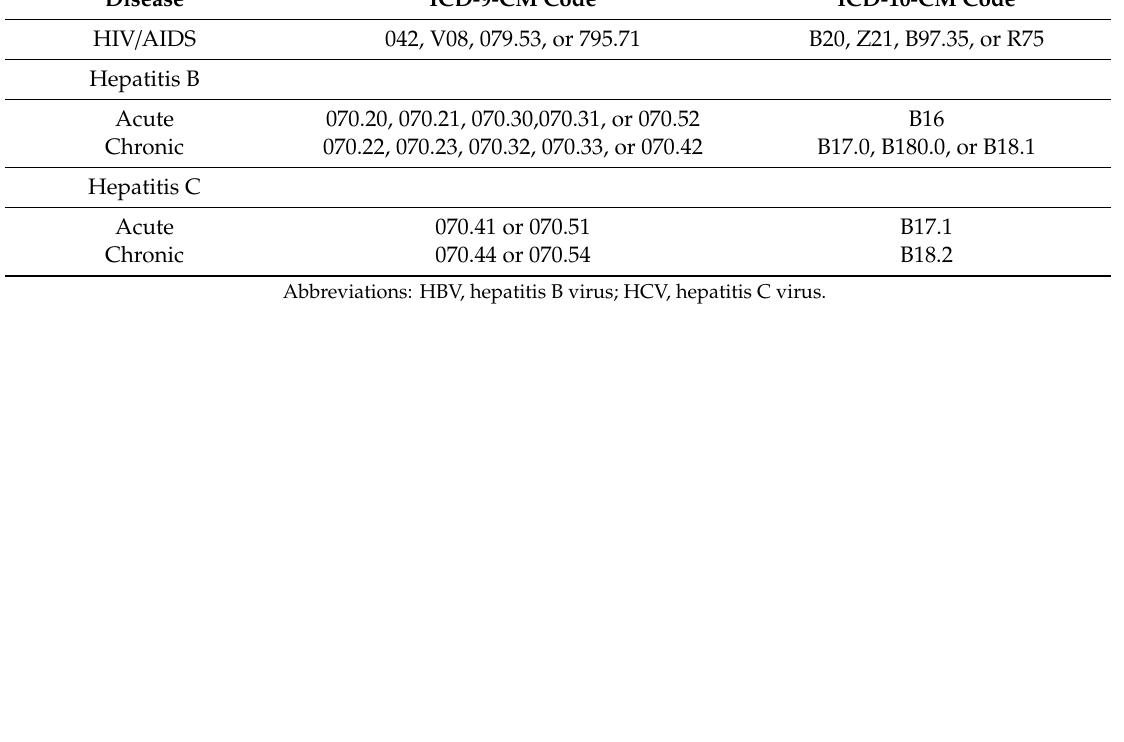
Table S1: Number and Percentage of Medicare Fee-for-Service Beneficiaries With or Without Opioid-related Claims Among Those Who Had Claims for HIV, HBV, or HCV, United States, 2015; Table S2: Number and Percentage of Medicare Fee-for-Service Beneficiaries Who Had Claims for Opioid-related Diagnoses, by Those with Claims for Opioid Overdose, United States, 2015; Table S3: Number and Percentage of Beneficiaries with Opioid Overdose Claims, a by Demographic Characteristics Among the Medicare Fee-for-Service Beneficiaries Who Had or Did Not Have HIV, b HBV, or HCV b Claims, United States, 2015; Table S4: Adjusted Odds Ratios (aORs) and 95% Confidence Intervals (CIs) for Association of Opioid Overdose Claims with ≥ 1 HIV, HBV, or HCV Infection Among Medicare Beneficiaries with Non-overdose Opioid-related Claims, United States, 2015; Table S5: Adjusted Odds Ratios (ORs) and 95% Confidence Intervals (CIs) for Association of Heroin Overdose Claims Among Medicare Beneficiaries With Non-overdose Opioid-related Claims, United States, 2015.